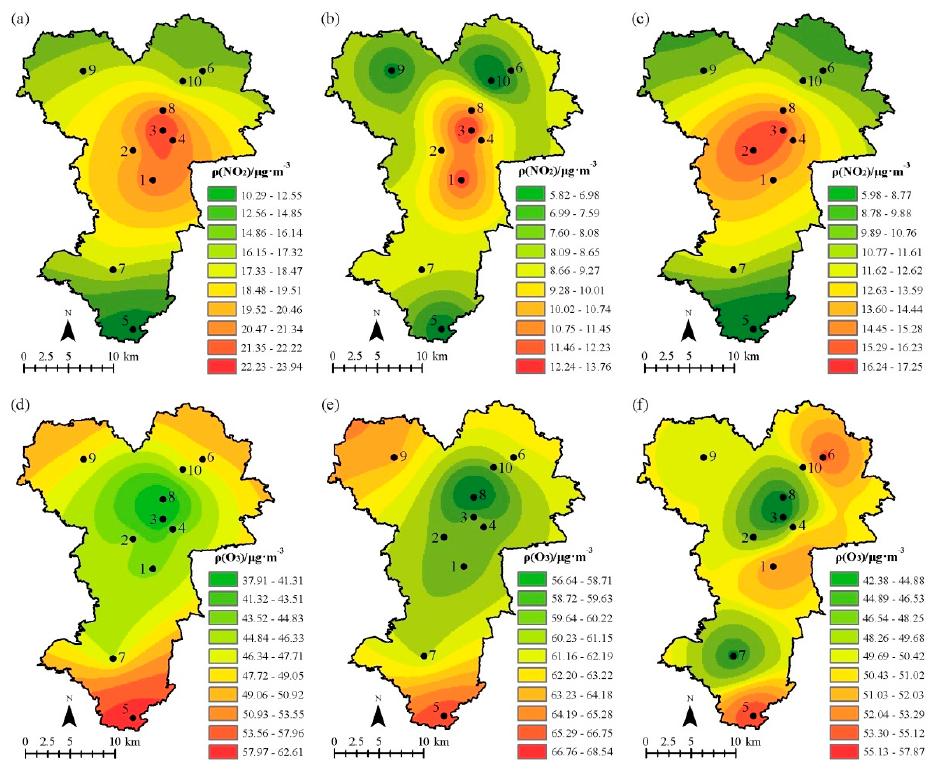
Figure 6. Spatial distribution of NO 2 and O 3 concentrations in urban Guiyang during the pre-lockdown, lockdown, and the identical lunar period over the last 3 years ( a , d ): Pre-lockdown; ( b , e ): Lockdown; ( c , f ): The identical lunar period during the past 3 years).